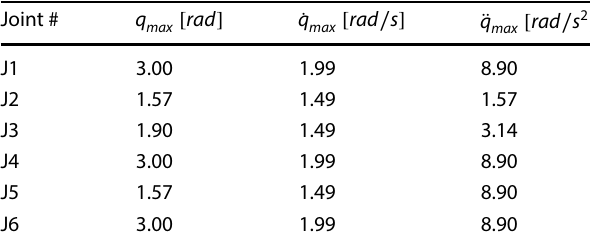
Table 1 Joint limits used for the experiment optimization